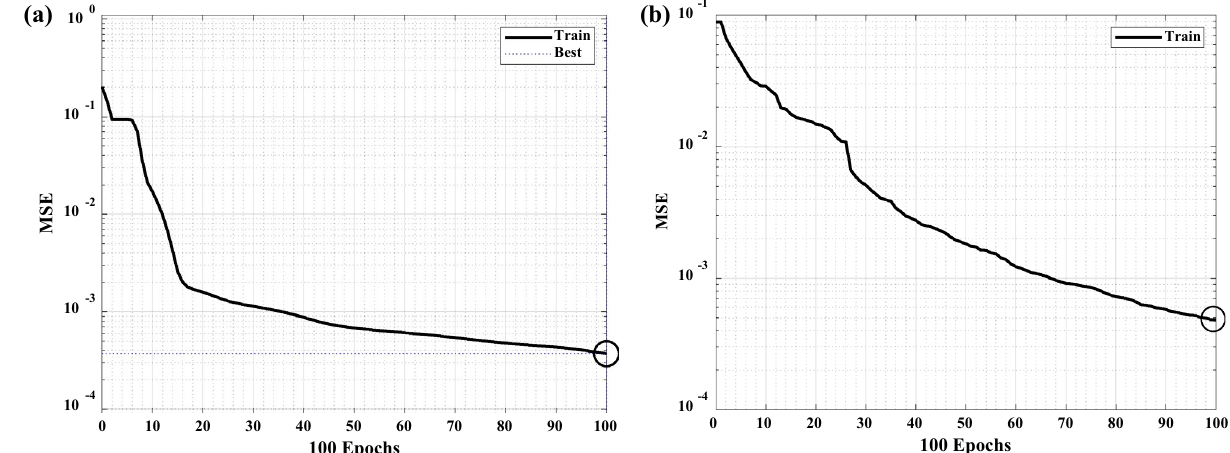
Figure 7. Comparison MSE of MLP ( a ) and RBF ( b ) models performance for the absorption